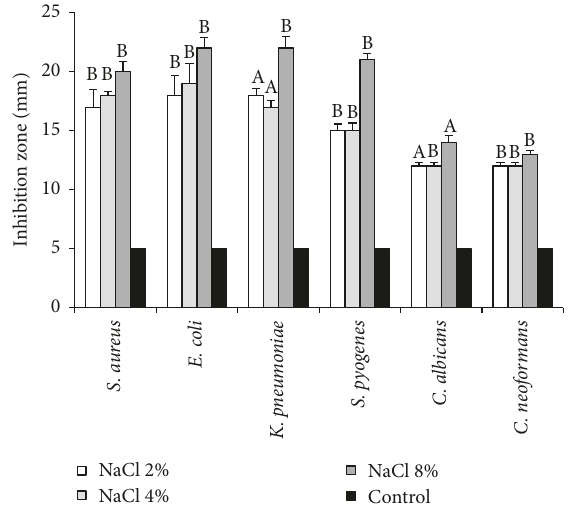
Figure 2: Effect of NaCl concentrations on the production and killing activity of killer toxin produced by D. hansenii against pathogenic bacteria and yeasts. Killer activity was measured by the means of inhibition zone around the wells. The shown data are the means and SD from three independent experiments. Values in the samecolumnfollowedbythesameletterarenotstatisticallydifferent by Duncan’s multiple range test at ( 𝑝 < 0.05